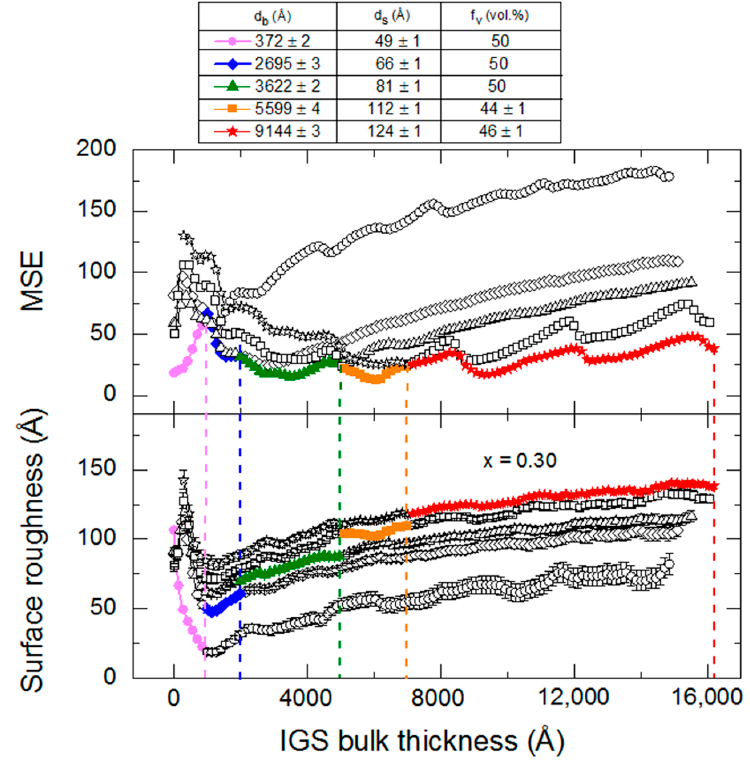
Figure 15. ( Lower panel) Surface roughness evolution for the IGS film with Ga composition x = 0.30, obtained applying five different pairs of ( ε 1 , ε 2 ) spectra in turn deduced by multi-time analyses of RTSE data centered at five different bulk layer thicknesses; ( upper panel) evolution of the mean square error (MSE) from the structural analyses using the five different ( ε 1 , ε 2 ) spectra. Solid points in the two panels highlight the lowest MSE results from among the five analyses. The inset above the panels shows the corresponding bulk layer thicknesses, surface roughness layer thicknesses and surface roughness layer void volume percentages at the center times of the five multi-time analyses.